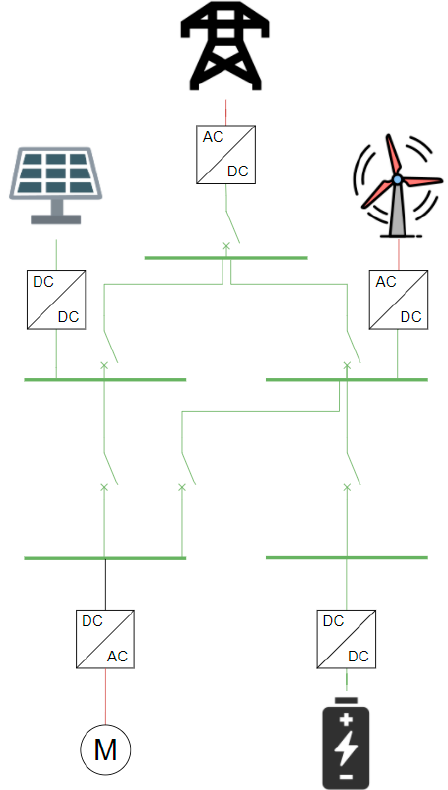
Figure 7. Mesh configuration.